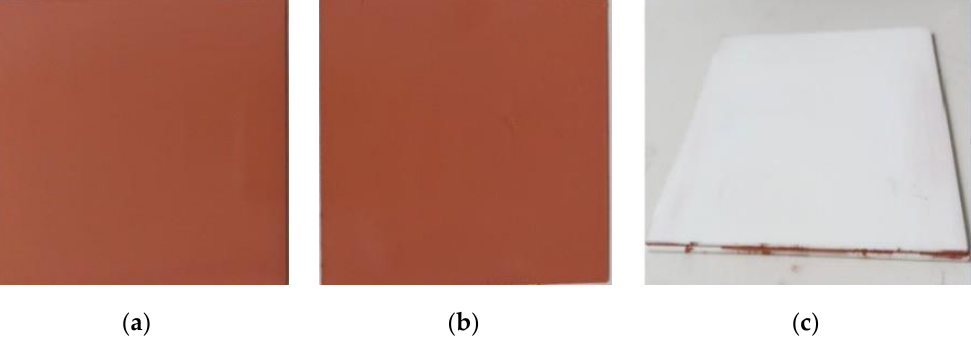
Figure 4. Fabrication process of the composite ceramic panel with a single magnetic interlayer: ( a )